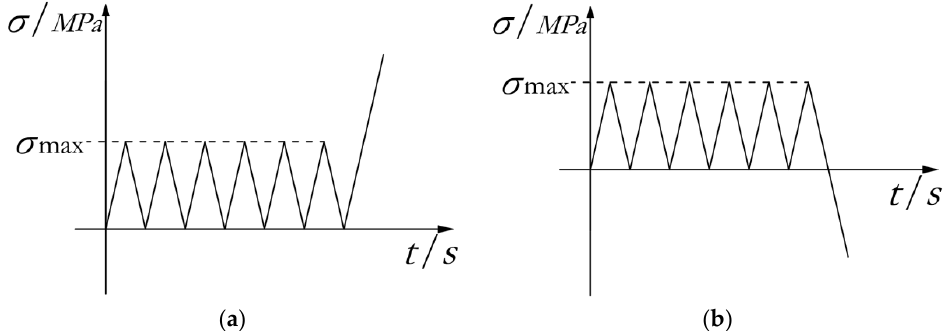
compressive load.